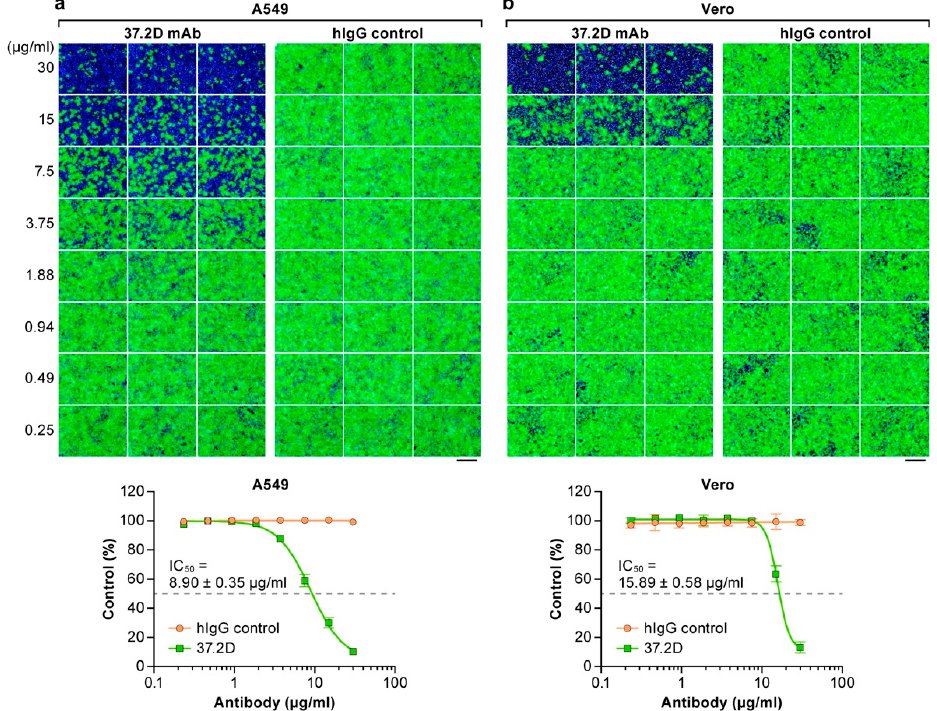
Figure 5. Neutralization assay based on recombinant GFP-expressing LASV (rLASV-GFP). rLASV-GFP was pre-incubated for 1 h with the indicated concentrations of a LASV-neutralizing human monoclonal antibody (37.2D) or human IgG isotype control (hIgG) and then added to A549 ( a ) or Vero ( b ) cells. GFP expression was assessed by high-content imaging. (Top) Representative images. (Bottom) The percentage of rLASV-GFP-infected cells in the presence of 37.2D antibody (green) and hIgG control (orange) was determined by high-content imaging. Error bars indicate the standard deviation of triplicate samples. The IC 50 for A549 cells was significantly lower than that for Vero cells (Student’s t -test, p <0.0001). Bar, 100 µm.